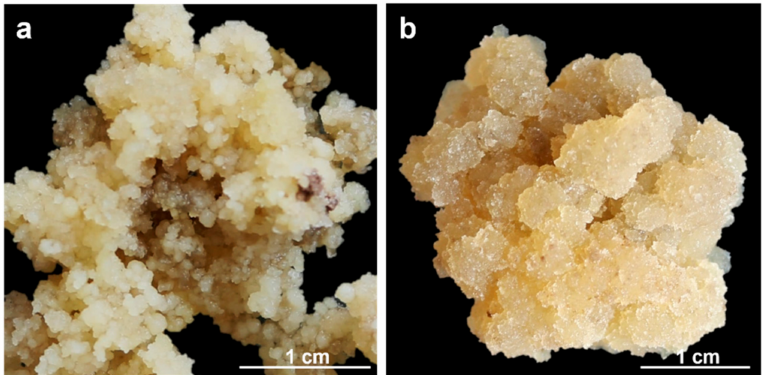
Figure 1. S. betaceum induced cell lines: ( a ) compact and embryogenic callus (EC); ( b ) friable and non-embryogenic callus